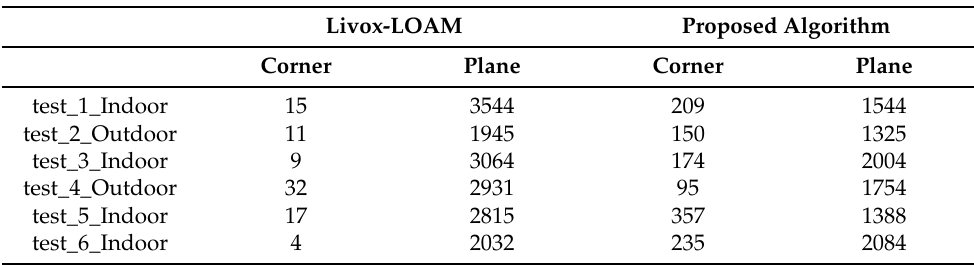
Table 2. Number of different feature points selected by Livox-LOAM and the proposed algorithm in 1 frame of Livox Mid-40 scan reading with the sensor running at 10